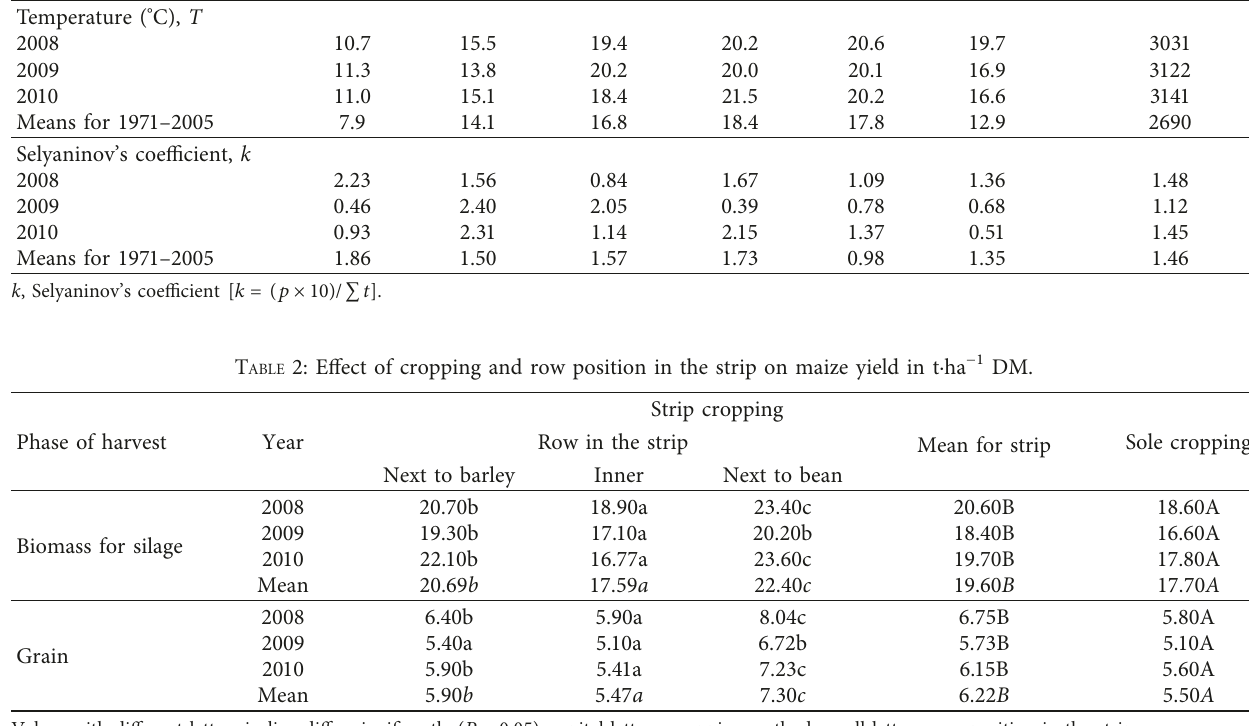
Next to barley Inner Next to bean